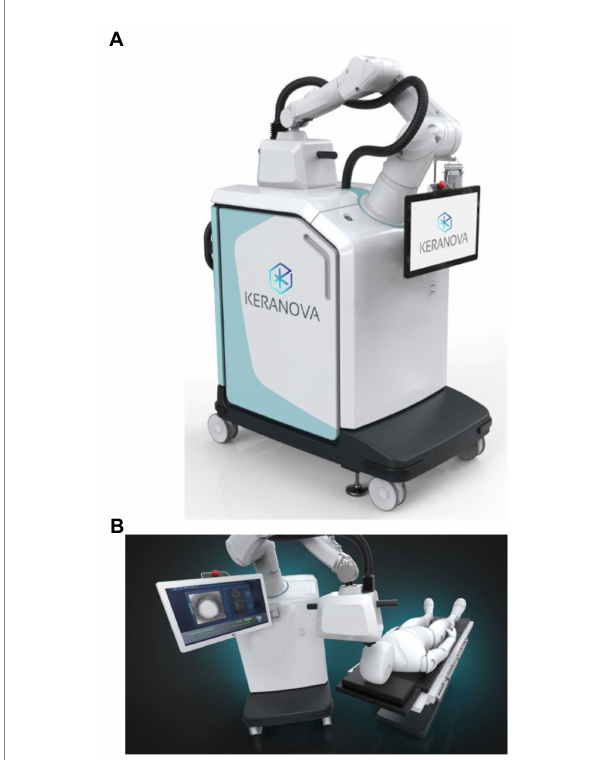
FIGURE 1 FemtoMatrix ® , a new robotic surgery system that uses femtosecond laser technology to treat cataracts. (A) Side view of the device, (B) view of the functioning device.